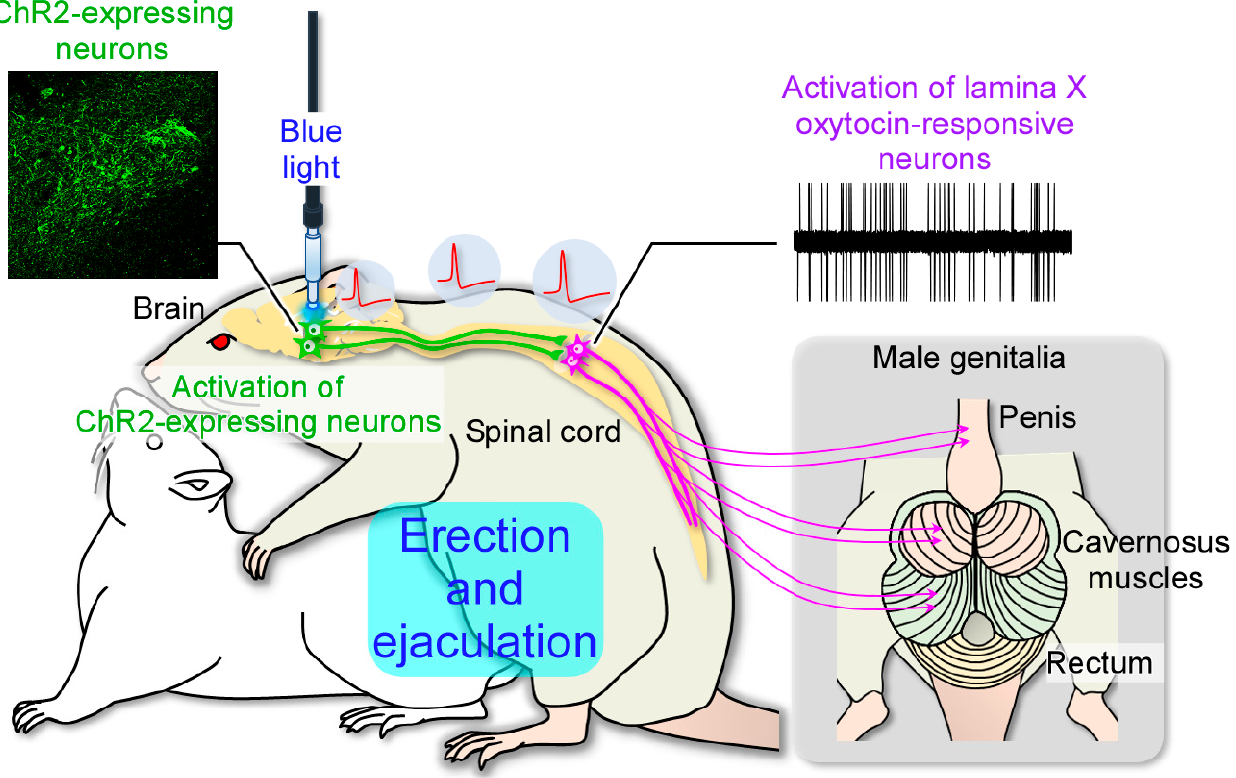
Figure 5. Schematic drawing summarizing the brain–spinal cord neural network that controls the male sexual function. A group of oxytocin neurons located in the posterior part of the paraventricular nucleus of the hypothalamus (PVH) project to the lower spinal cord and control penile erection and ejaculation in male rats. The lamina X oxytocin-responsive neurons containing gastrin-releasing peptide (GRP) project axons to spinal centers of the lumbosacral cord that mediate penile reflexes and trigger ejaculation.